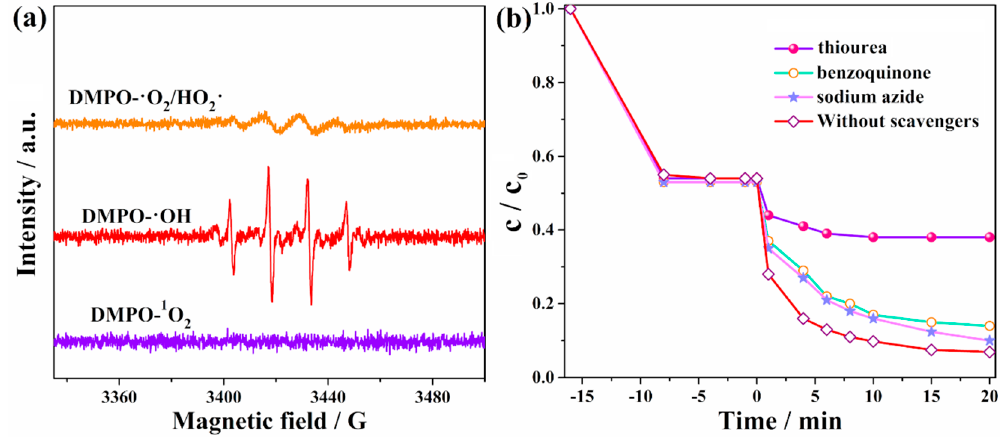
Figure 6. ( a ) Electron paramagnetic resonance (EPR) spectra in the systems for the degradation